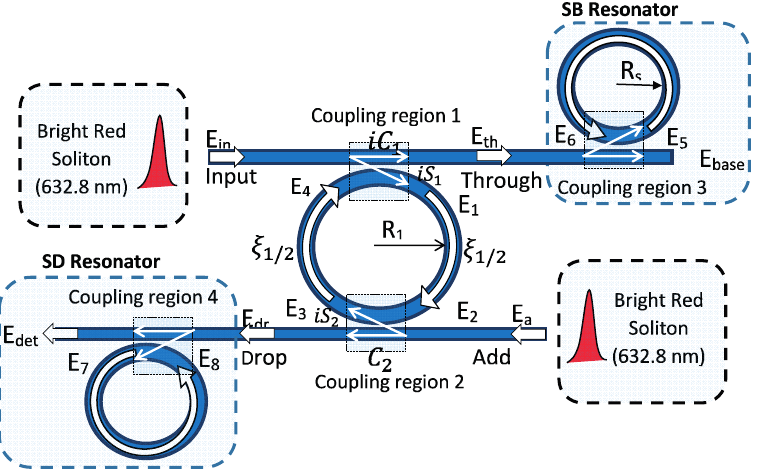
Figure 4. Schematic diagram of the DR-ADF microring